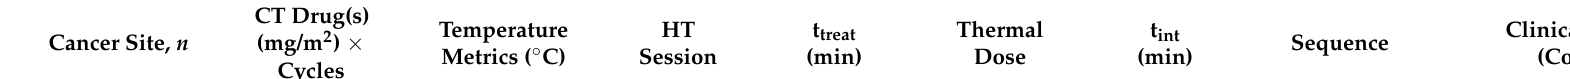
Table 10. Retrospective clinical trial studies using CT in combination with